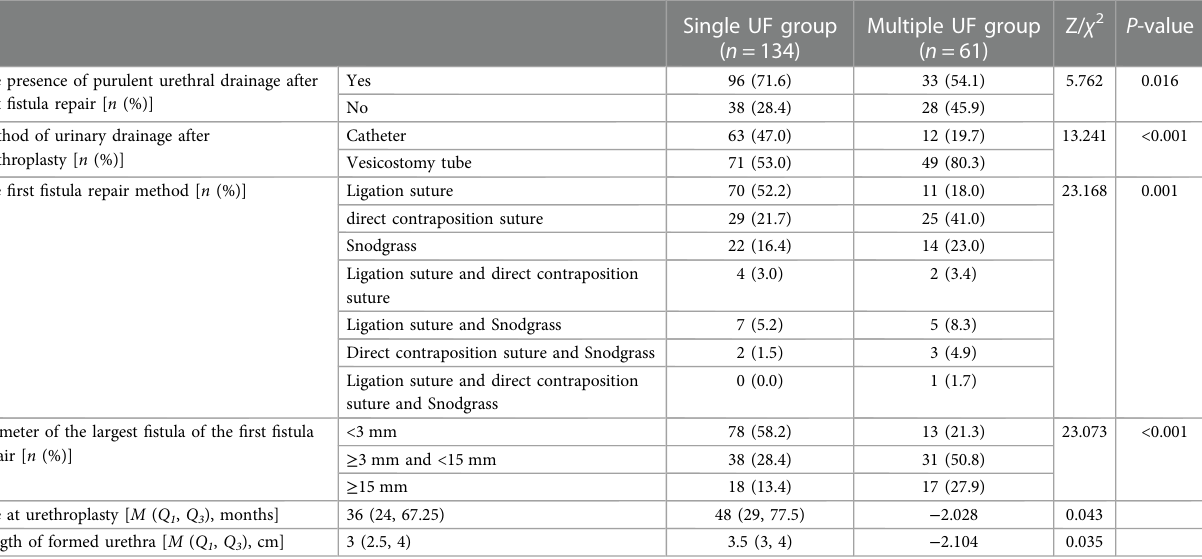
TABLE 2 Univariate regression analysis of multiple UF after